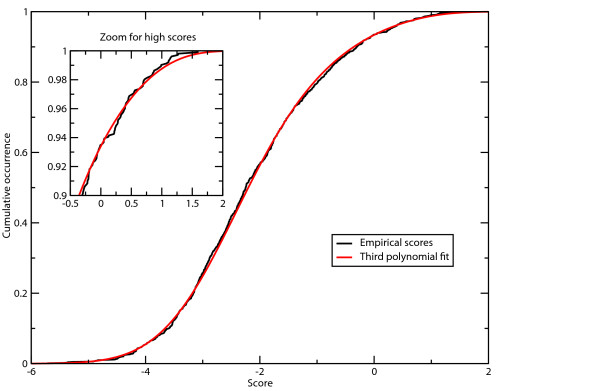
Approximation of the empirical score distribution of non-phosphorylated sites. The empirical score distribution was approximated using equations 16 and 17. With a correlation coefficient of 0.9988, the applied polynomial fit of 3rd order provides a sufficiently accurate approximation of the expected false-positive rate. The parameters with respect to equation 17 are: u = -1.76847, λ1 = -0.766775, λ2 = 0.166677 and λ3 = -0.0298602. The polynomial fit was calculated using the XMGRACE tool [81].